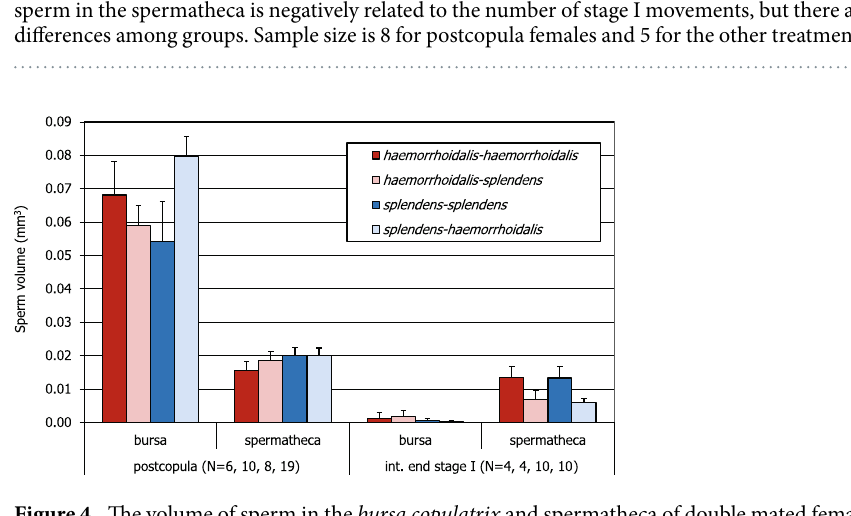
Figure 4. The volume of sperm in the bursa copulatrix and spermatheca of double mated females after intraspecific and interspecific matings (postcopula treatment; the male species is indicated first in the legend), compared to the volume stored by females mated to a conspecific male and then to a conspecific or heterospecific male, but interrupted at the end of stage I (60–120 movements), before insemination. The volume of sperm in the bursa is reduced by 97–100%. The volume of the spermatheca in intraspecific matings is reduced by 14% in C. haemorrhoidalis and 33% in C. splendens . In contrast, volume reduction is 63–71% in interspecific